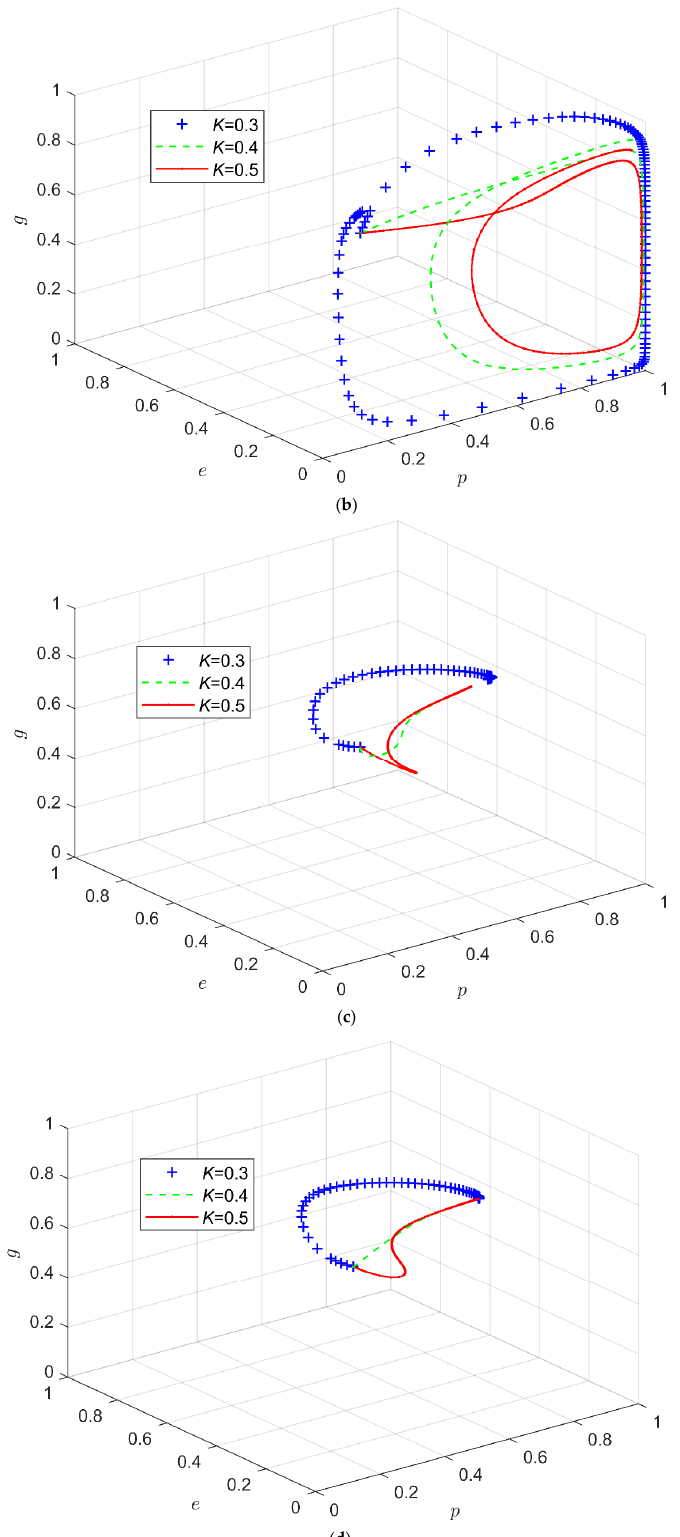
Figure 2. ( a ) Influence of cost sharing ratio on system evolution under static reward and static penalty system. ( b ) Influence of cost sharing ratio on system evolution under dynamic reward and static penalty system. ( c ) Influence of cost sharing ratio on system evolution under static reward and dynamic penalty system. ( d ) Influence of cost sharing ratio on system evolution under dynamic reward and dynamic penalty system.